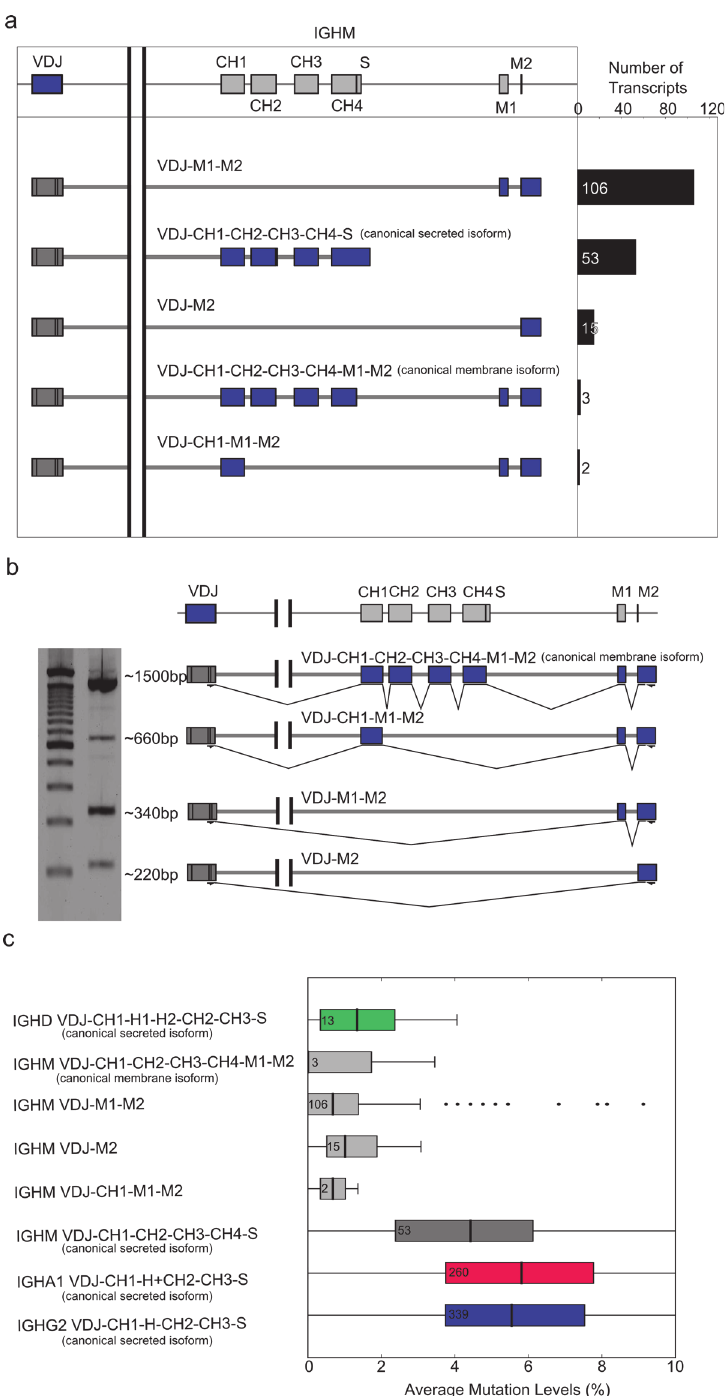
Figure 2. Alternative splicing of IGHM transcripts. a) RNA was extracted from bulk B cells and the IGH transcripts were analyzed using the PacBio sequencer (IGH-Seq) and mapped to the IGHM locus. Reads containing the whole VDJ region as well as either S or M exons were grouped and quantified. Several reads represented abundant novel short IGHM isoforms lacking structural exons. b) Gel separation of amplicons generated from bulk B cell RNA using primers specific for exon J4 and putative exon IGHA M2 is shown on theleft. Schematic representation of isoform splice structure as validated by Sanger sequencing is shown on the right. The bands of several sizes confirmed the presence of short IGHM isoforms found by single molecule sequencing. c) Mutation rates of different IGH isoforms derived from PacBio reads shown